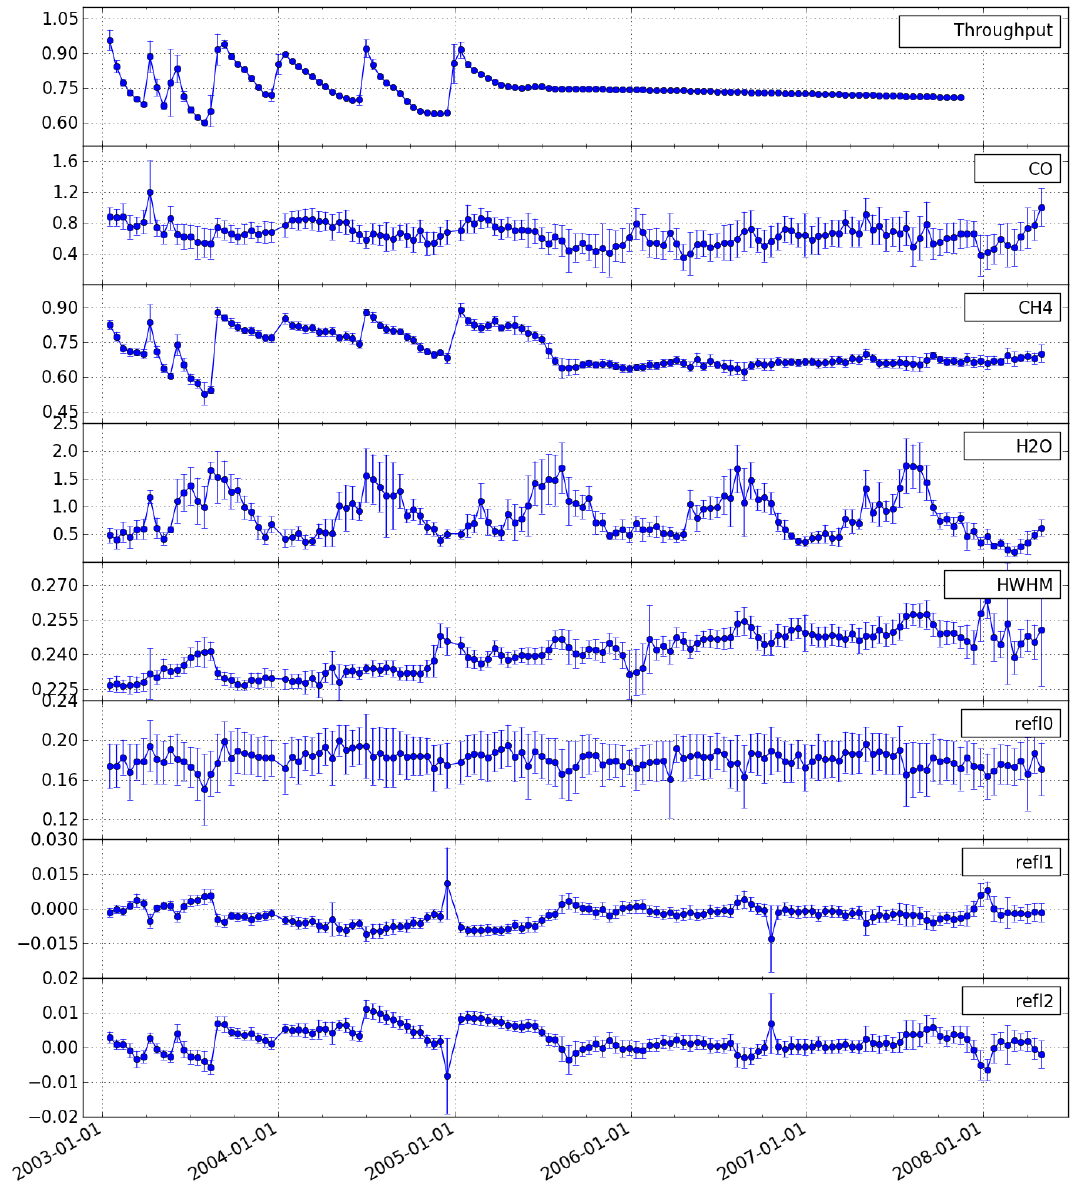
Fig. 12. Time series of 14-day averaged fit parameters included in CO retrievals in channel 8. From top down: the mean channel transmission (throughput), the scaling factors of CO, CH 4 and H 2 O, the half width at half maximum of the instrument slit function, and the zeroth, first, and second degree coefficients of the albedo polynomial. See the dependency of some parameters on throughput.